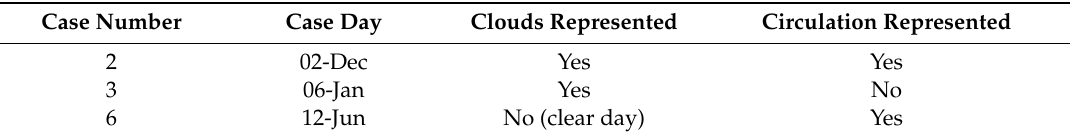
Table 3. Description of cases for bias exploration.